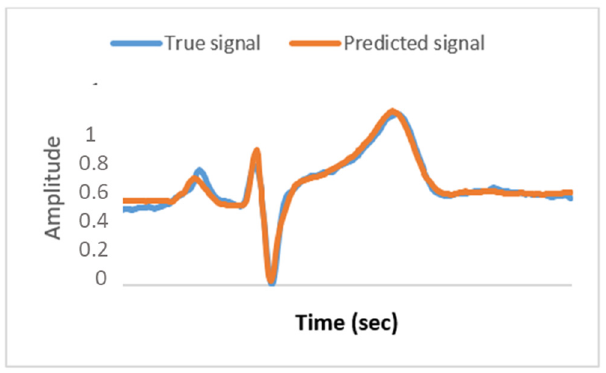
Figure 7. R 2 Values for the different number of inputs: Optimized method results.